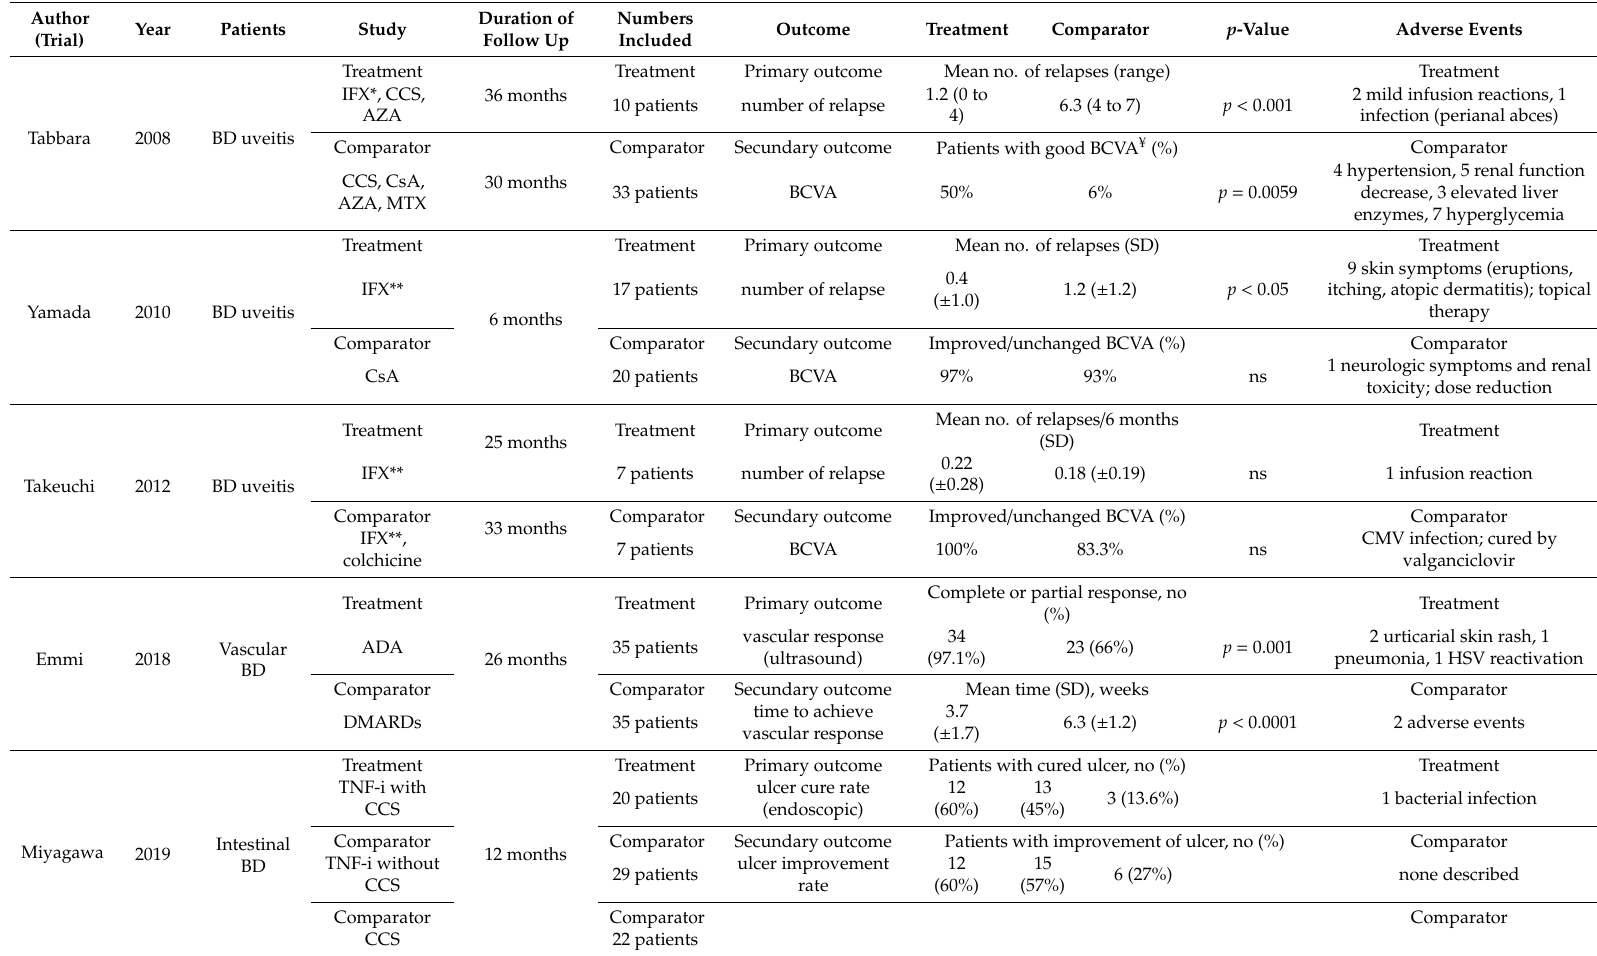
Table 2. Retrospective comparative trials with anti TNF- α agents and